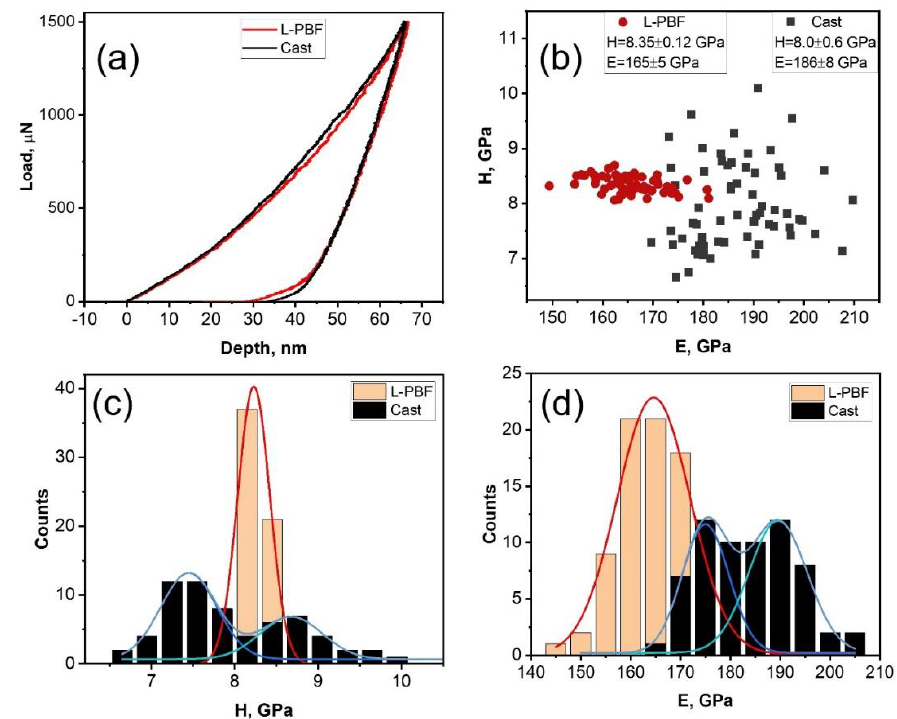
Figure 7. Typical load-depth curves ( a ), hardness vs. modulus plot for each indentation ( b ), hardness (H) ( c ) and modulus (E) ( d ) distributions for the cast and L-PBF samples. L-PBF fabricated sample demonstrates much more narrow distribution of the prop- erties due to single-phase structure, some value dispersion is due to dendritic liquation. High dispersion of hardness and modulus of the cast alloy (Figure 7b) reflects its complex two-phase microstructure. However, predominantly bimodal distributions of the proper- ties (Figure 7c,d) allows to evaluate the properties of each phase. It should be noted that the elastic modules of the phases in the cast alloy are higher than that of the solid solution in the L-PBF fabricated sample. BCC phases in L-PBF sample are predominantly disor- dered solid solutions (Table 2) with metallic bonding; in contrast to them, the cast alloy is composed of BCC_B2 and σ-phase, both are intermetallic compounds with partially cova- lent rigid bonding, which imparted higher value of elastic modulus to the cast alloy. 4. Conclusions In the present study, the powder of FeCoCrNiMo 0.5 Al 1.3 HEA was synthesized via gas atomization and then used for laser powder bed fusion and microplasma spraying pro- cesses. Microstructure and phase composition stability were studied. FeCoCrNiMo 0.5 Al 1.3 in equilibrium state consists of B2 and σ-phase. Gas atomization led to a formation of partially ordered BCC super saturated solid solution with insignifi- cant Mo-rich and Al-rich segregations. The alloy remained single-phase after powder con- solidation via laser powder bed fusion procedure. The non-equilibrium solid solution de- composes with B2 and σ-phase formation only after annealing at 900 °C for 1 h. Maximal microhardness (950 HV) was obtained for the powder and the L-PBF sam- ple annealed at 600 °C, which is caused by increasing element segregation and growth of elastic stresses. After annealing at 900 °C microhardness slightly decreased (850 HV) but